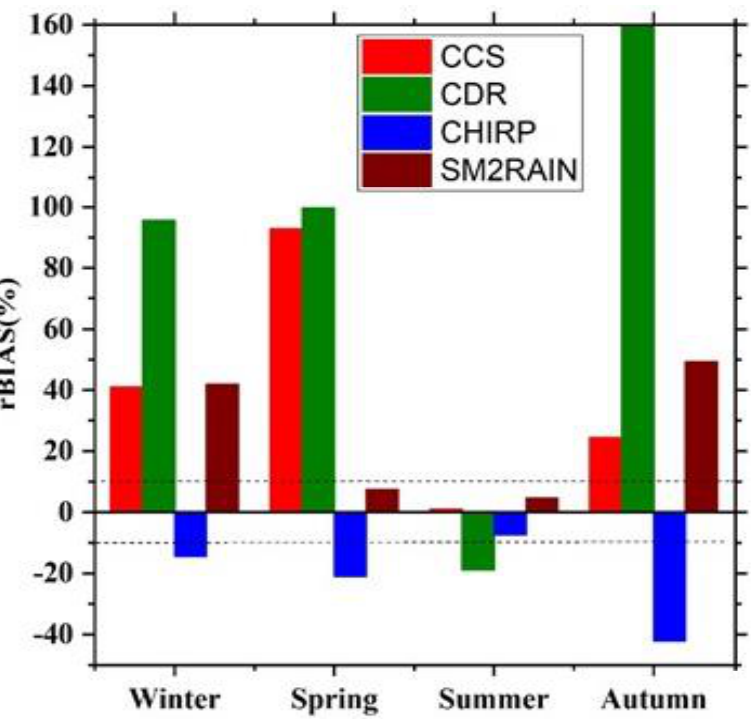
Figure 11. Seasonal variations in the estimated values of the rBIAS for the PERSIANN-CCS, PERSIANN-CDR, SM2Rain-ASCAT, and CHIRPS-2.0 products.